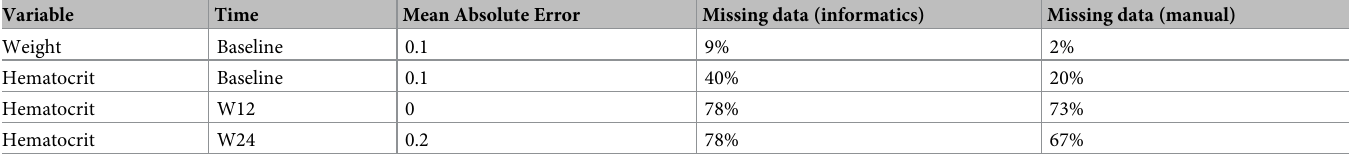
Table 3. Comparison of the results of non-PRO3, continuous CDAI elements by manual vs informatics methods. Mean absolute error was calculated only for values that were non-missing by both informatics and manual methods. Comparisons were made against the annotations performed by one chart reviewer (45 patients), roughly a quarter of the 183 patients who met all eligibility criteria prior to application of the baseline CDAI requirement.